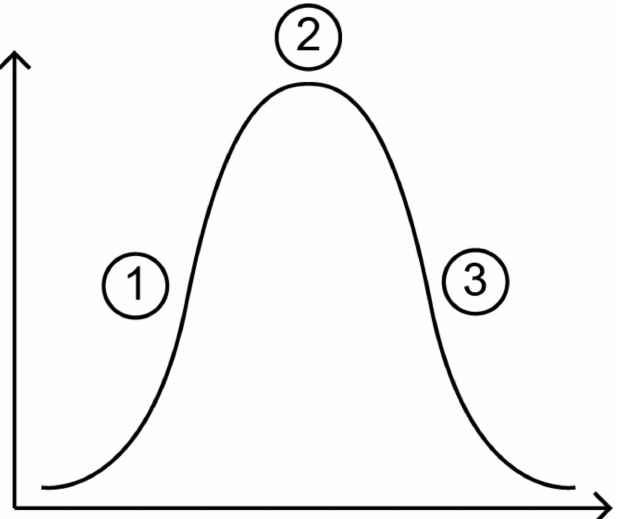
Figure 2. A standard bell curve graph, a normal distribution with a rounded peak tapering away at each